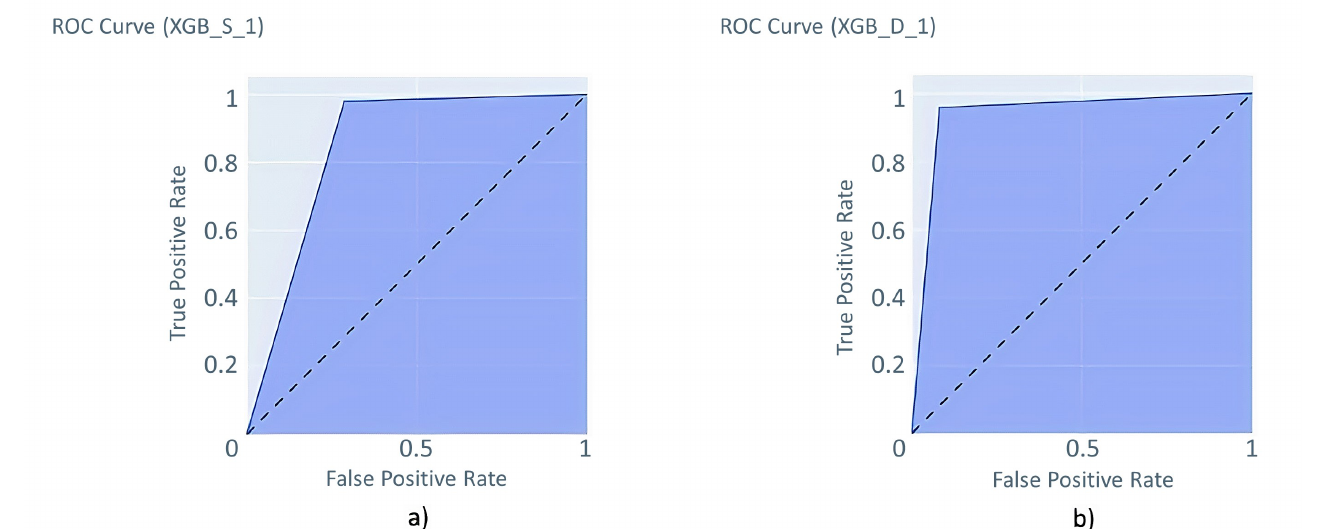
Figure 5. ROC for the best models: ( a ) ROC for XGB_S_1 model; ( b ) ROC for XGB_D_1